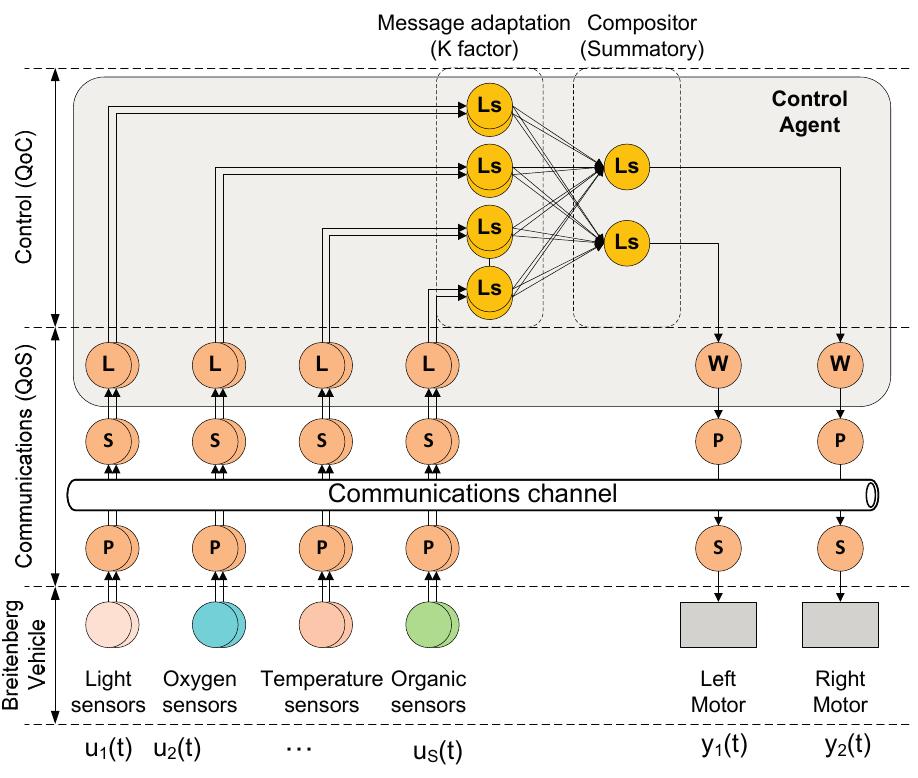
Figure 20. FSACtrl architecture implementation of the Braitenberg 3.c